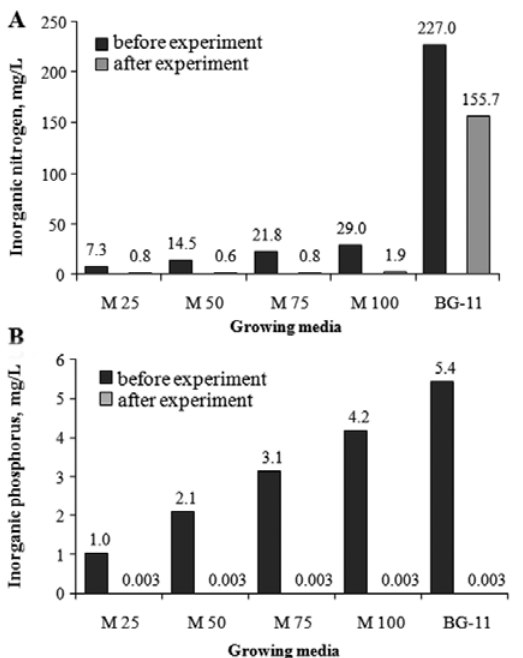
Fig. 6. The inorganic nitrogen (A) and inorganic phosphorus (B) concentrations in the media before and after the